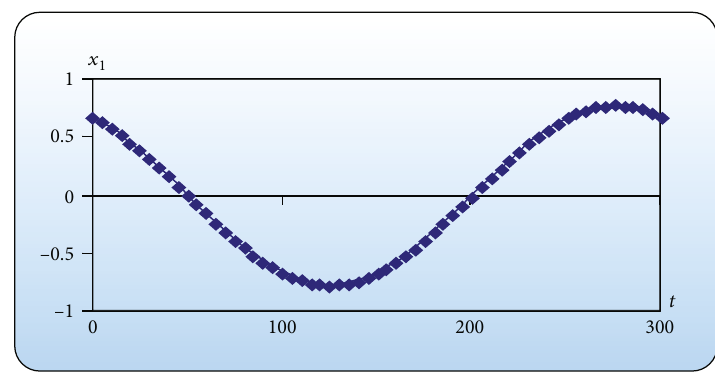
Figure 3: The numerical solution x